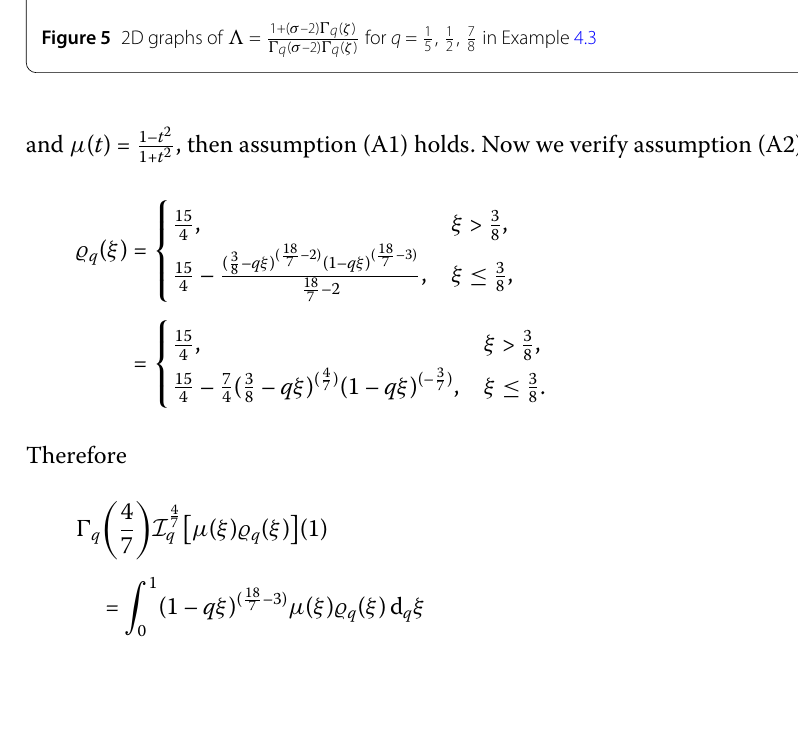
for q = 1 , 1 , 7 in Example 4.3 5 2 8